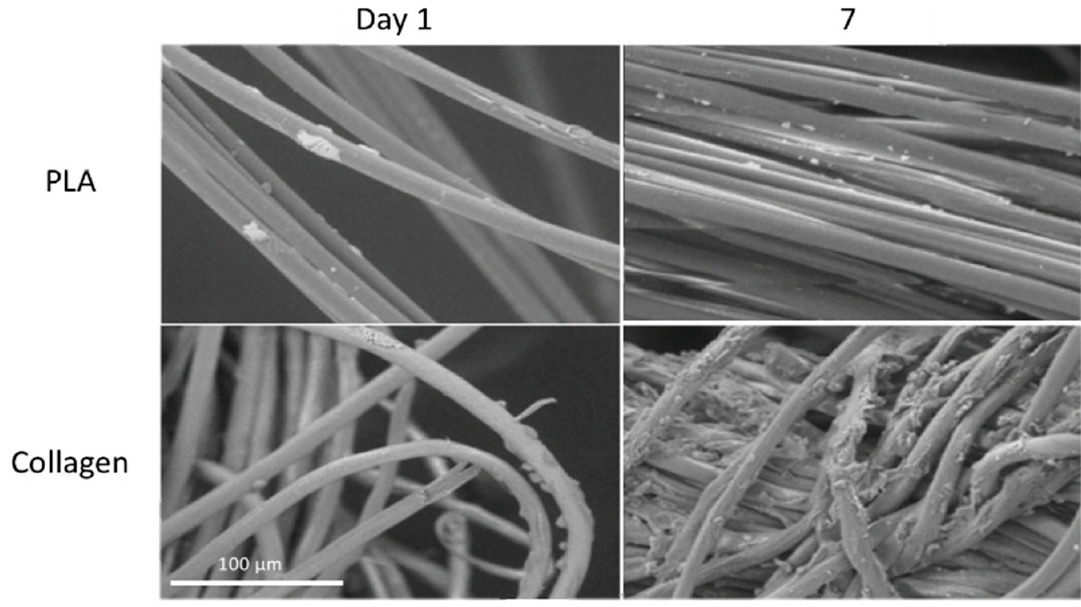
Figure 2. Representative SEM images of cells maintained on collagen and PLA scaffolds at days 1 and 7 with 500 × magnification. Cells adhered along the length of the collagen yarns at day 7, compared to the limited cell adhesion on PLA yarns at the same timepoint. Scale bars = 100 µ